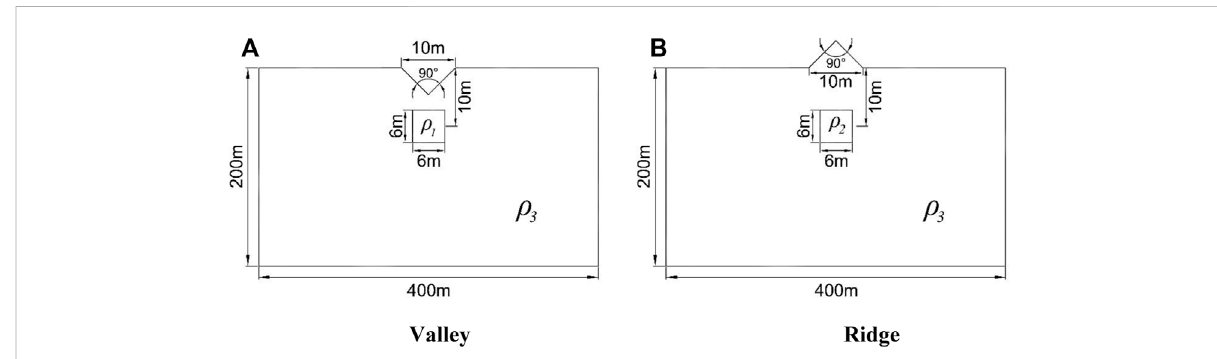
FIGURE 2 Model 1 geometry for (A) valley and (B)